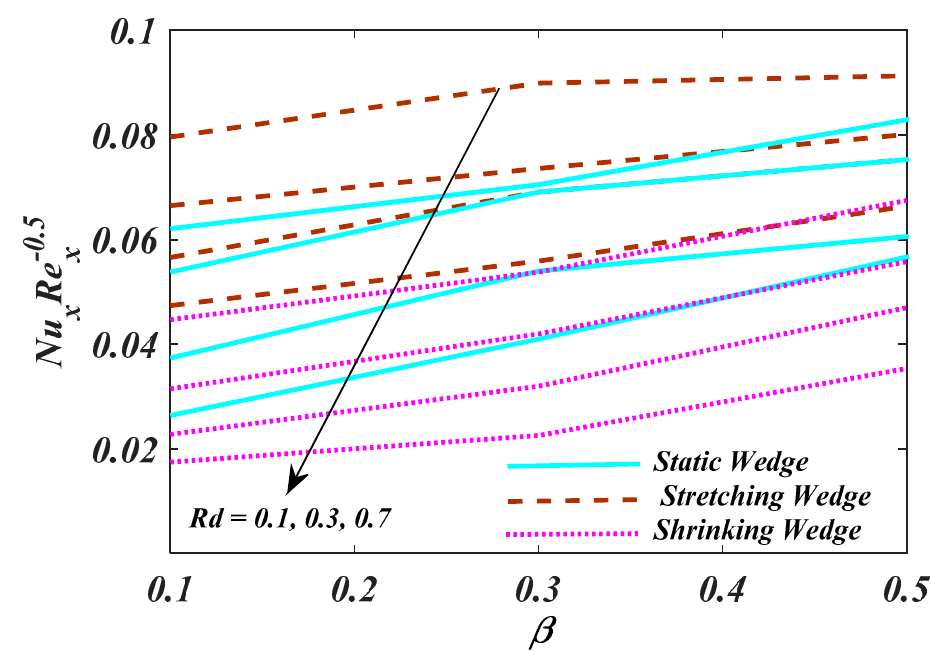
Figure 12. Plot of (cid:1844)(cid:1857) (cid:3051)(cid:2869)/(cid:2870) (cid:1829) (cid:3033) with variations in (cid:1839) (cid:1853)(cid:1866)(cid:1856) (cid:1849) .